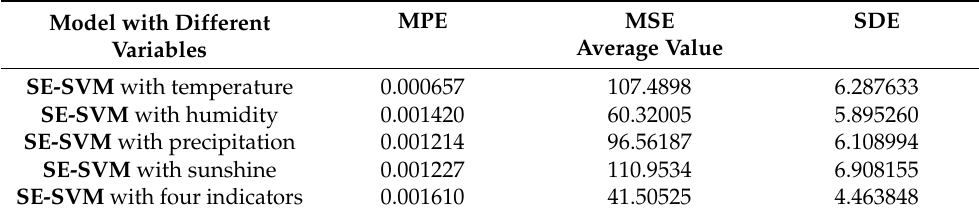
Table 4. Forecasting NOH using different model settings. Model with